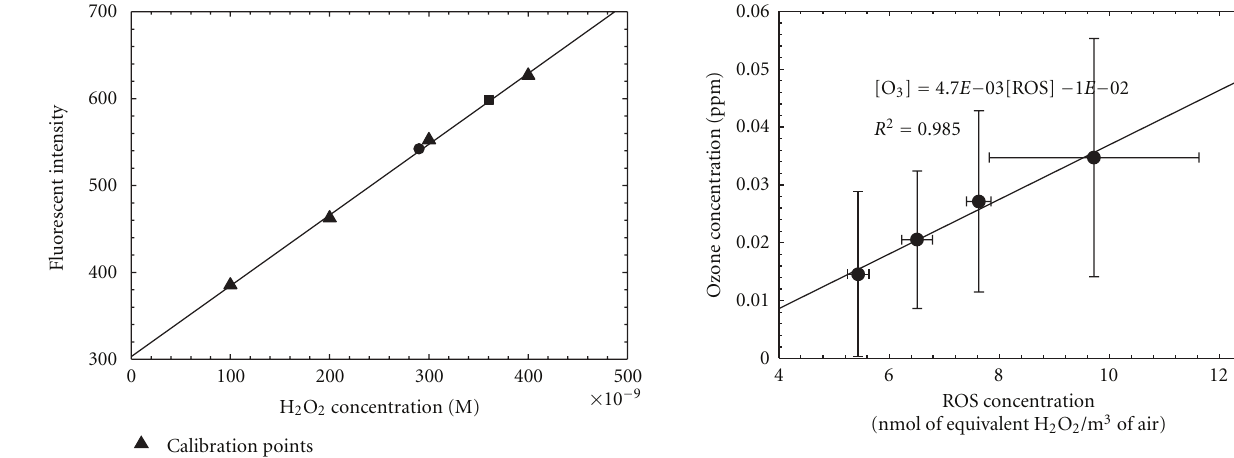
Figure 9: Correlation between mean ozone concentrations and mean particle-bound ROS concentrations (error bars represent standard